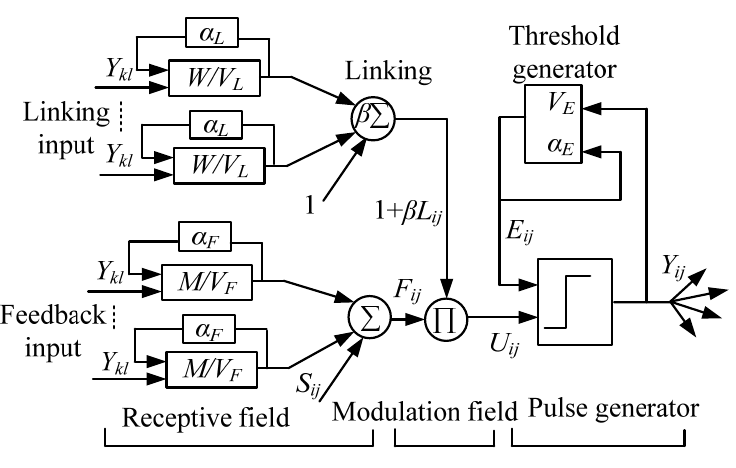
Figure 11. PCNN neural structure